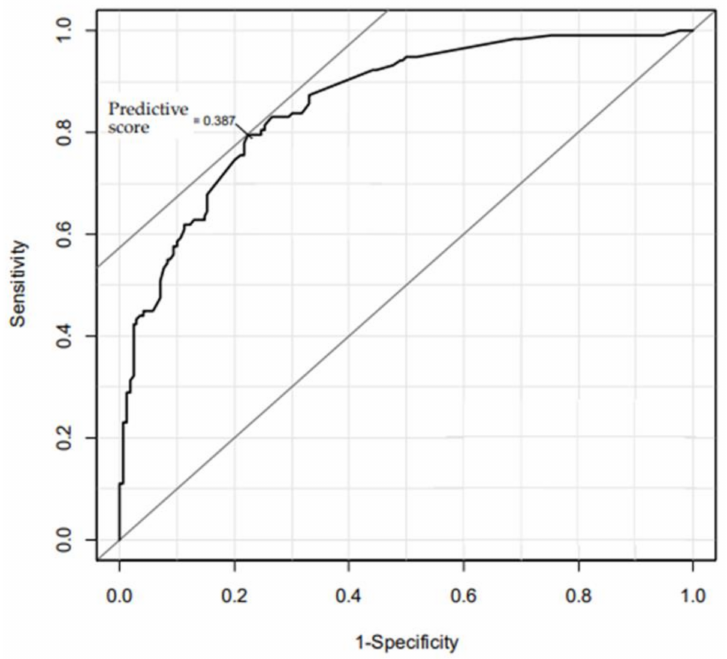
Figure 1. ROC curves for the predictive model of having difficulties in raising children by predictive